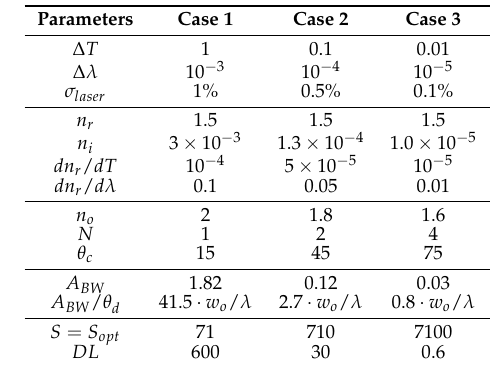
Table 1. Results from the application of the optimization protocol to three hypothetical scenarios.